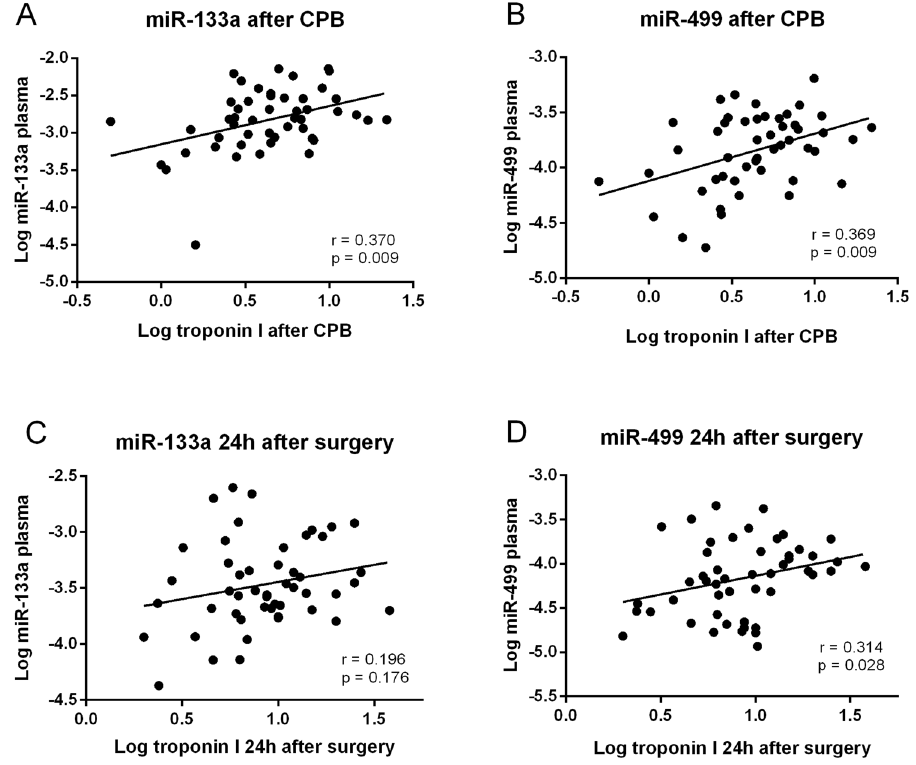
Figure 3. Correlations between plasma miRNA expression and troponin I concentrations. Spearman rank correlations between circulating miR-133a ( A , C ) or miR-499 ( B , D ) and troponin I concentrations immediately ( A , B ) and 24 h after surgery ( C , D